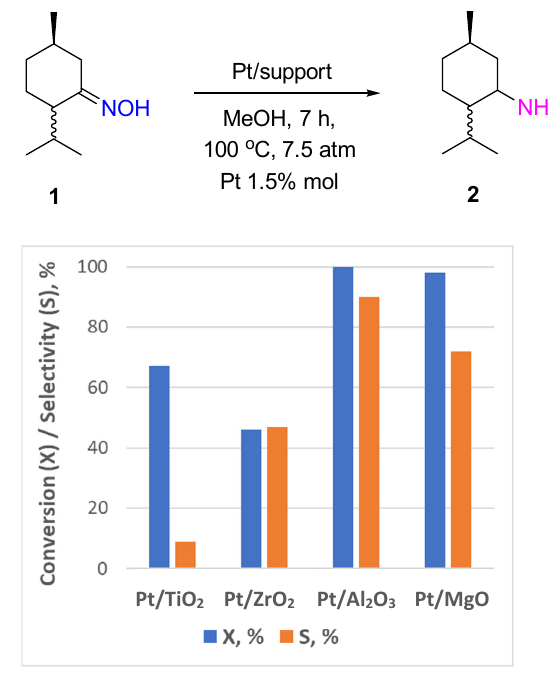
Figure 1. Hydrogenation of menthone oxime over Pt ‐ supported catalysts.